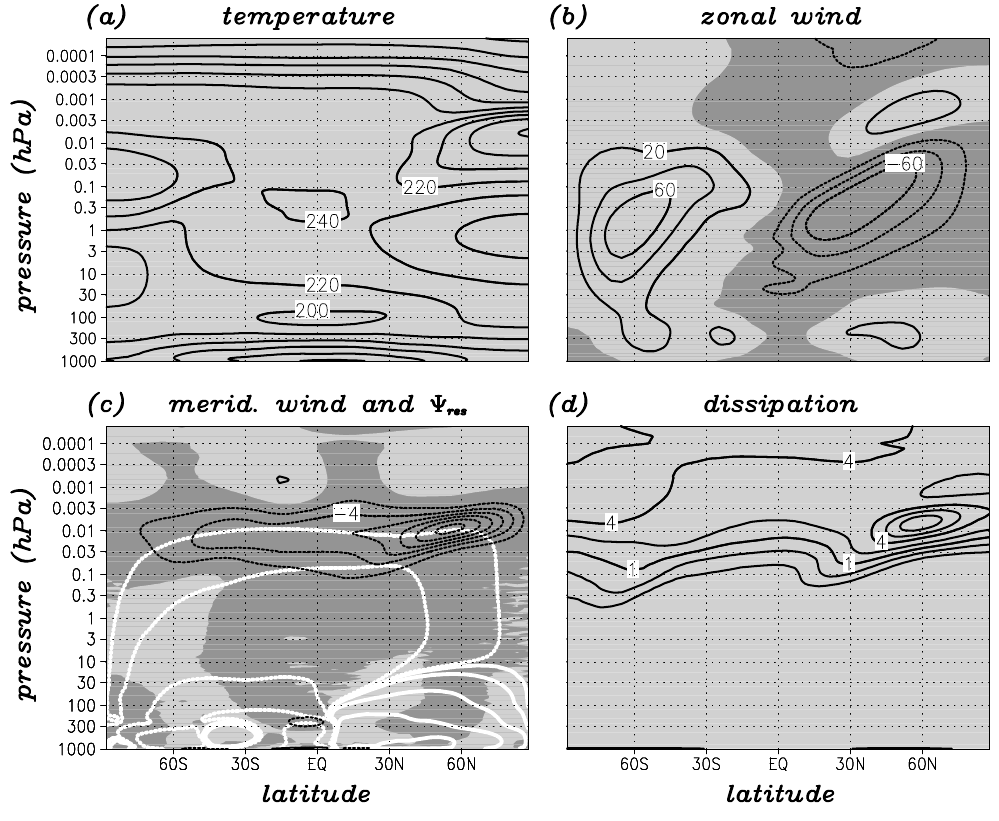
Fig. 4. Zonal-mean climatology for “July 2002” conditions. (a) Temperature (contour interval 20 K). (b) Zonal wind (contour interval 20ms − 1 ). (c) Eulerian meridional wind (contour interval 2ms − 1 ). (d) Dissipation (contours 0 . 25 , 0 . 5 , 1 , 2 , 4 , 6 , 8Kd − 1 ). Zero contours are not drawn. Positive and negative values are indicated by light and dark shading. The additional white contours in (c) show the residual mass streamfunction 9 res (contours ± 0 . 01 , 0 . 1 , 1 , 10 , 100 × 10 9 kgs − 1 ).